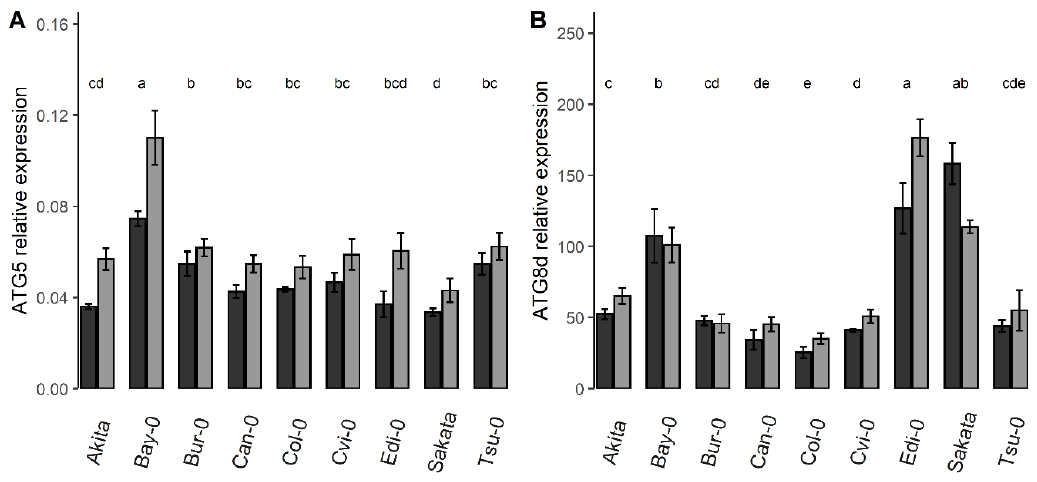
Figure 4. Genetic effect on the ATG transcript levels among accessions in the control and starvation conditions. Bars are the relative expressions of ATG5 ( A ) and ATG8d ( B ) in nine Arabidopsis accessions grown in the control and N starvation conditions (means ± SE). Letters indicate significant distinct groups of accession ( p < 0.05, n = 8). Dark and light greys show the plant in the control and N starvation conditions, respectively.